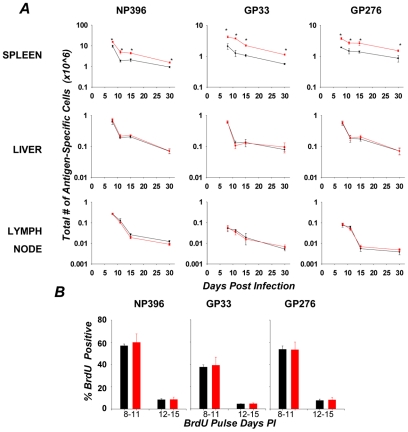
Effect of FOXO3 deficiency on contraction of CD8 T cells.(A) +/+ and FOXO3−/− mice were infected with LCMV and at the indicated days PI, cells from spleen, liver and lymph nodes were stained with anti-CD8 and MHC-I tetramers. Data are representative of 3 to 8 independent experiments with 4–6 mice/group/experiment for each indicated time point. (B) +/+ and FOXO3−/− mice were infected with LCMV and given a BrdU injection at either 8 or 12 days PI and administered BrdU in drinking water between either days 8–11 or 12–15 PI. At the end of each BrdU pulse (day 12 or day 15), splenocytes were stained with anti-CD8, MHC-I tetramers and anti-BrdU. The percentage of BrdU positive cells amongst tetramer binding CD8 T cells for each pulse (8–11, or 12–15 days PI) was determined by flow cytometry. Data are the mean of at least 6 +/+ or FOXO3−/− mice/group.